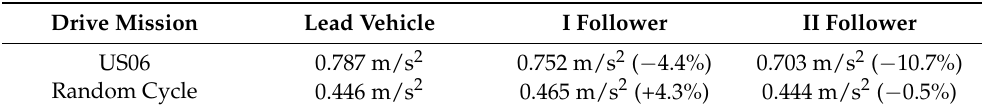
Table 3. Comfort analysis